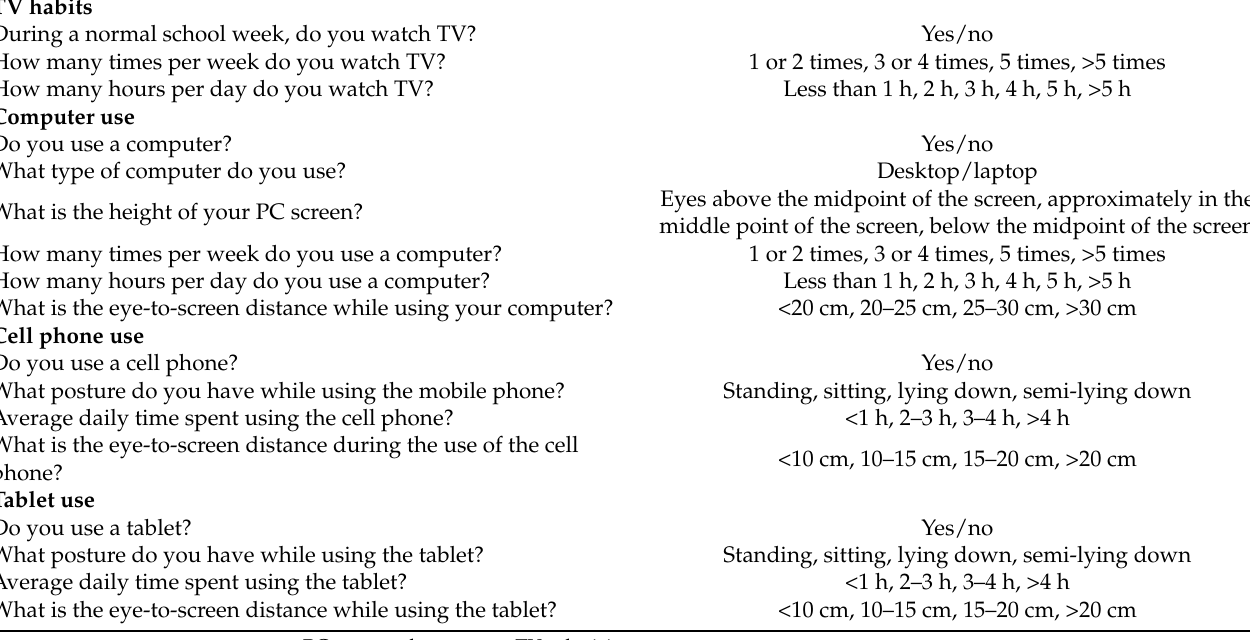
Table 1. Questions and answers about electronic equipment